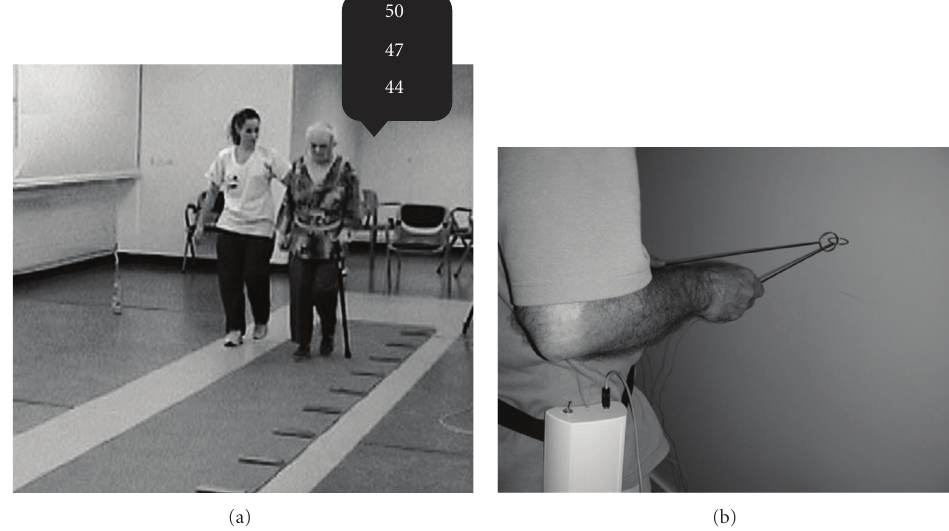
Figure 5: Assessment of steady-state balance performance. (a) 10 m walk test with concurrent cognitive interference task (i.e., counting backwards by three). (b) 10 m walk test with concurrent motor interference task (i.e., holding two interlocked sticks steady in front of the